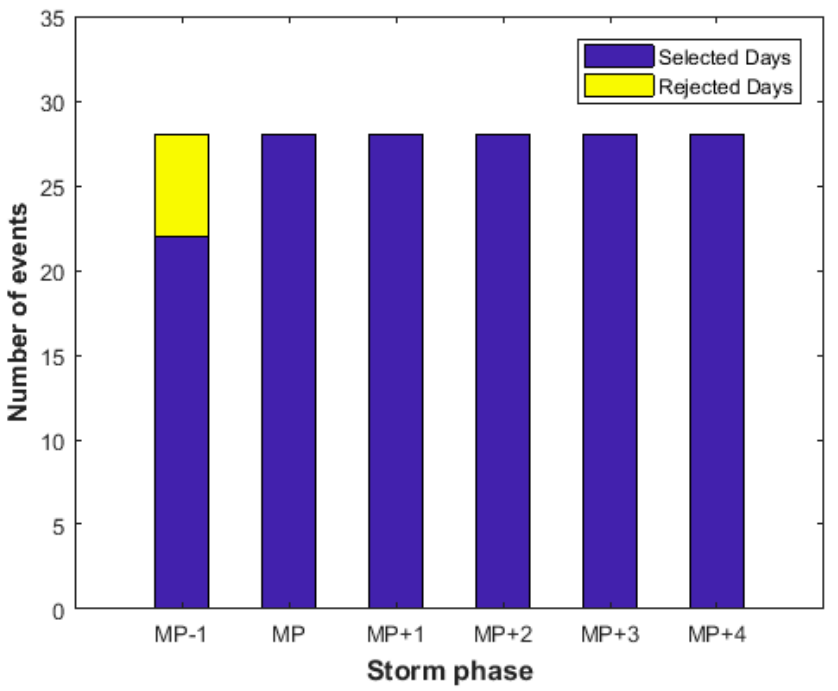
Figure 7. The distribution of the number of events selected (blue) and rejected (yellow) used in analyzing the occurrence of TEC enhancements during different geomagnetic storm phases.